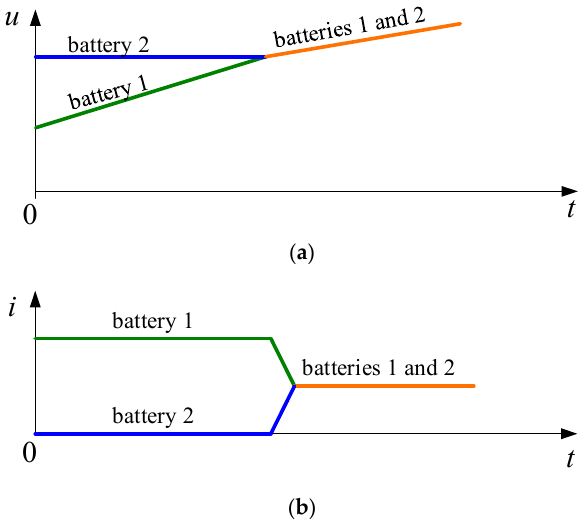
Figure 8. Principal charge balancing timing diagram: (a) voltage of two batteries with different charge; (b) cell charging current.